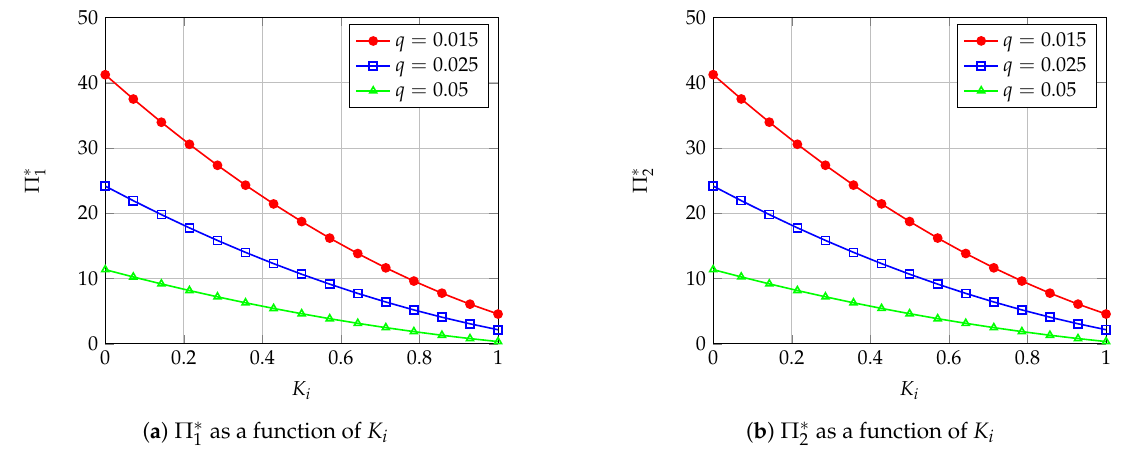
Figure 5. MNOs profits as a function of K i .